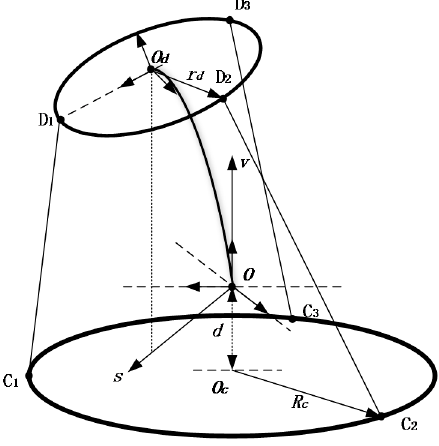
Figure 4. Coordinates and kinematic analysis of the waist twist device.